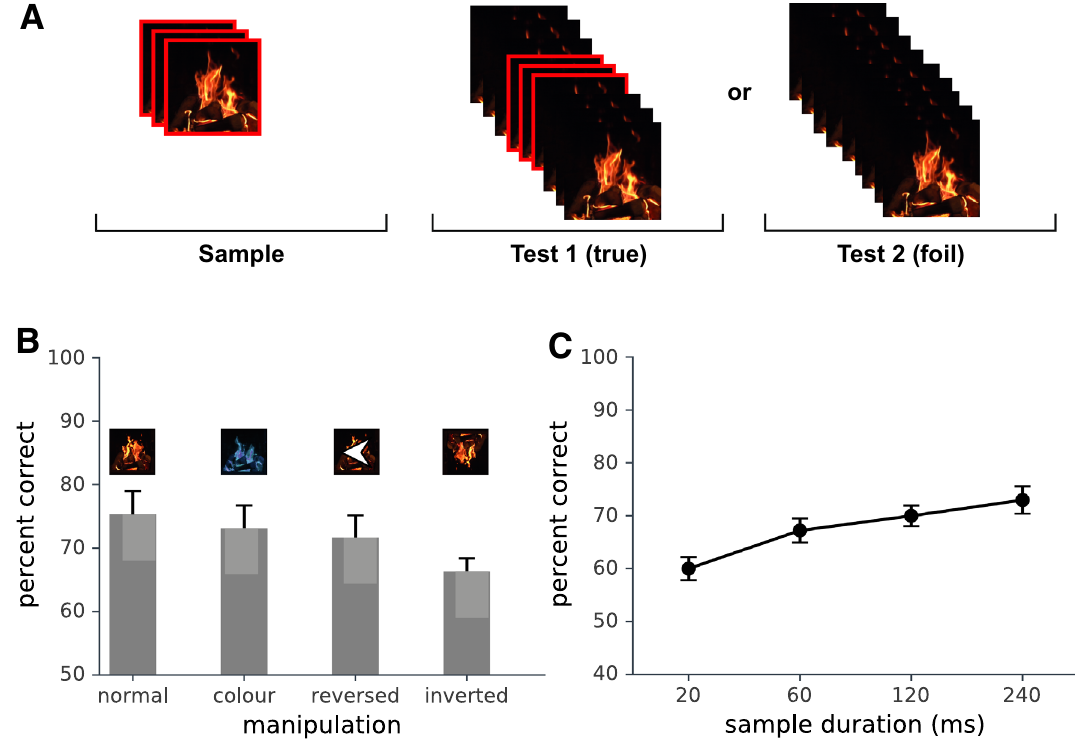
Figure 1. ( A ) The basic task: a short movie clip of a hearth fire (200 ms) was presented on each trial, followed by two longer sequences (300 ms), one which contained the target clip. ( B ) Experiment 1: target recognition under four manipulations. The target clip was left unaltered, hue negated, temporally reversed or spatially inverted. ( C ) Experiment 2: target detection as a function of sample